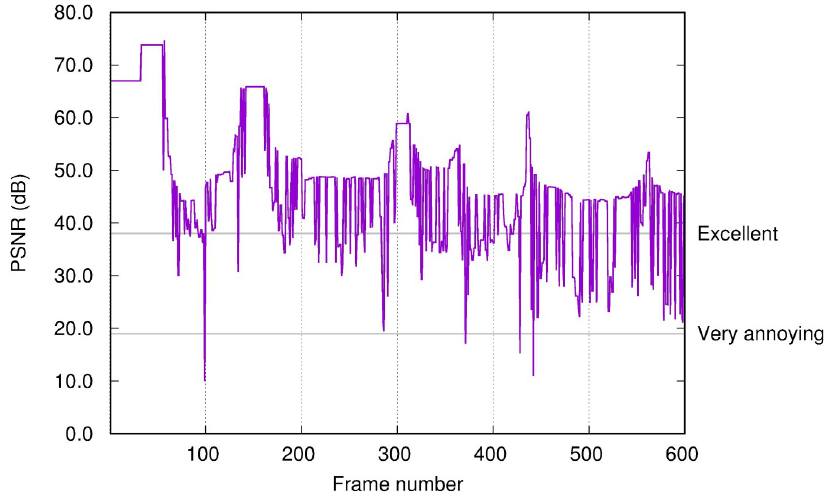
Fig 7. PSNR time series for video profile in Amazon